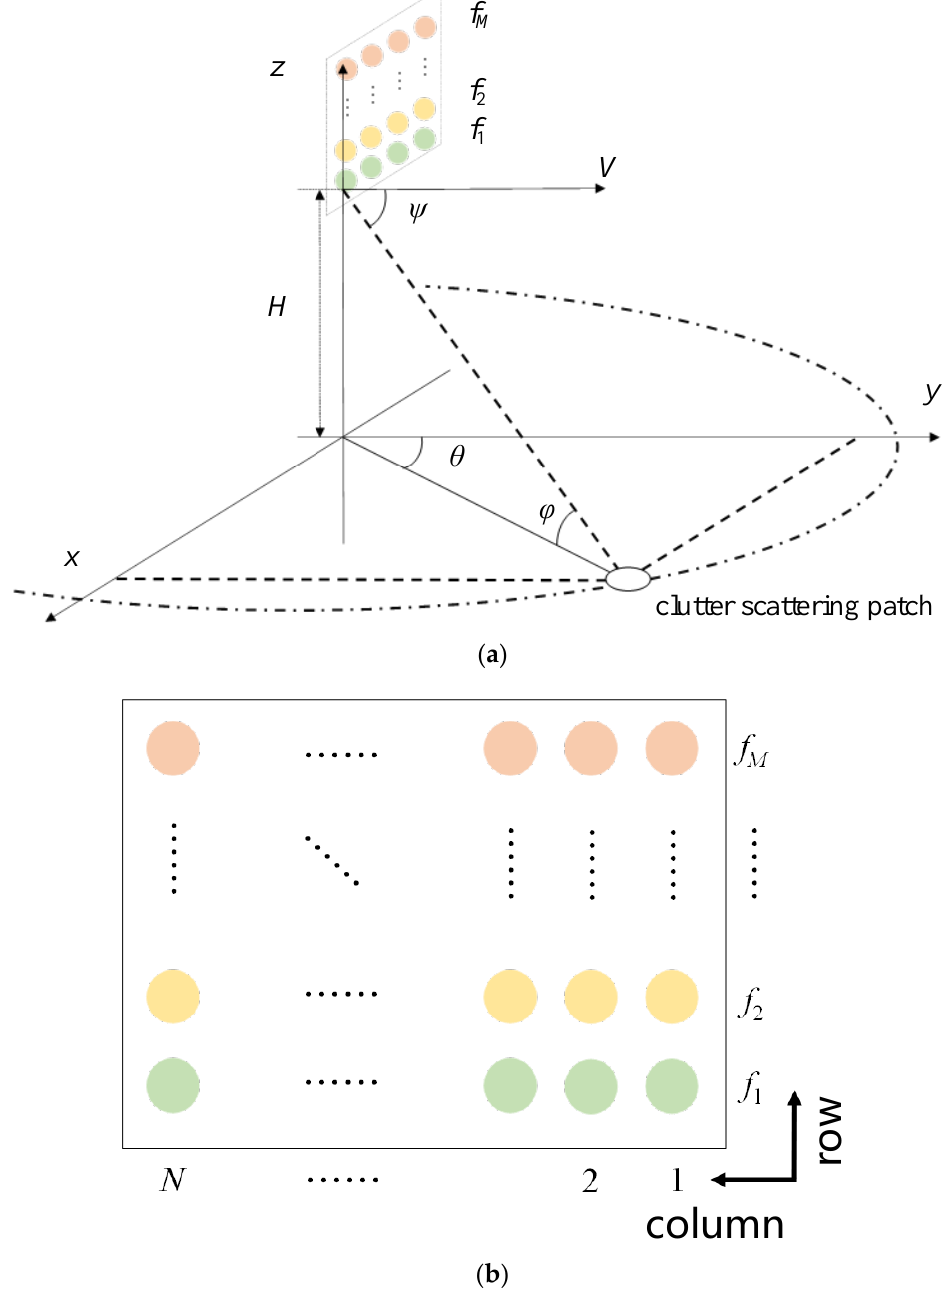
Figure 1. Geometry of FDA-MIMO planar array radar. ( a ) Schematic diagram of FDA- MIMO planar array radar clutter geometric distribution; ( b ) schematic diagram of the planar array geometric